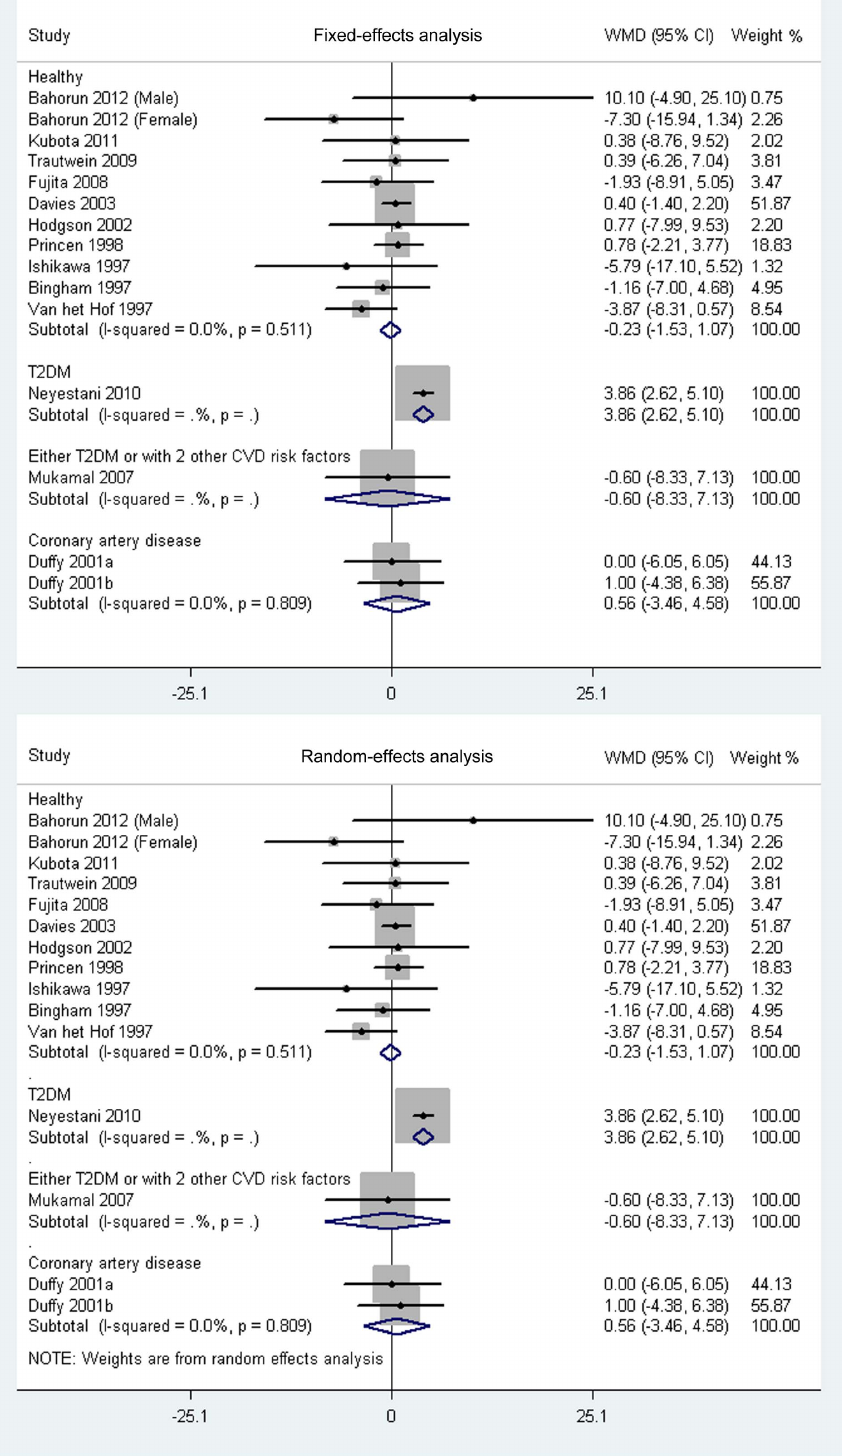
PLOS ONE | www.plosone.org